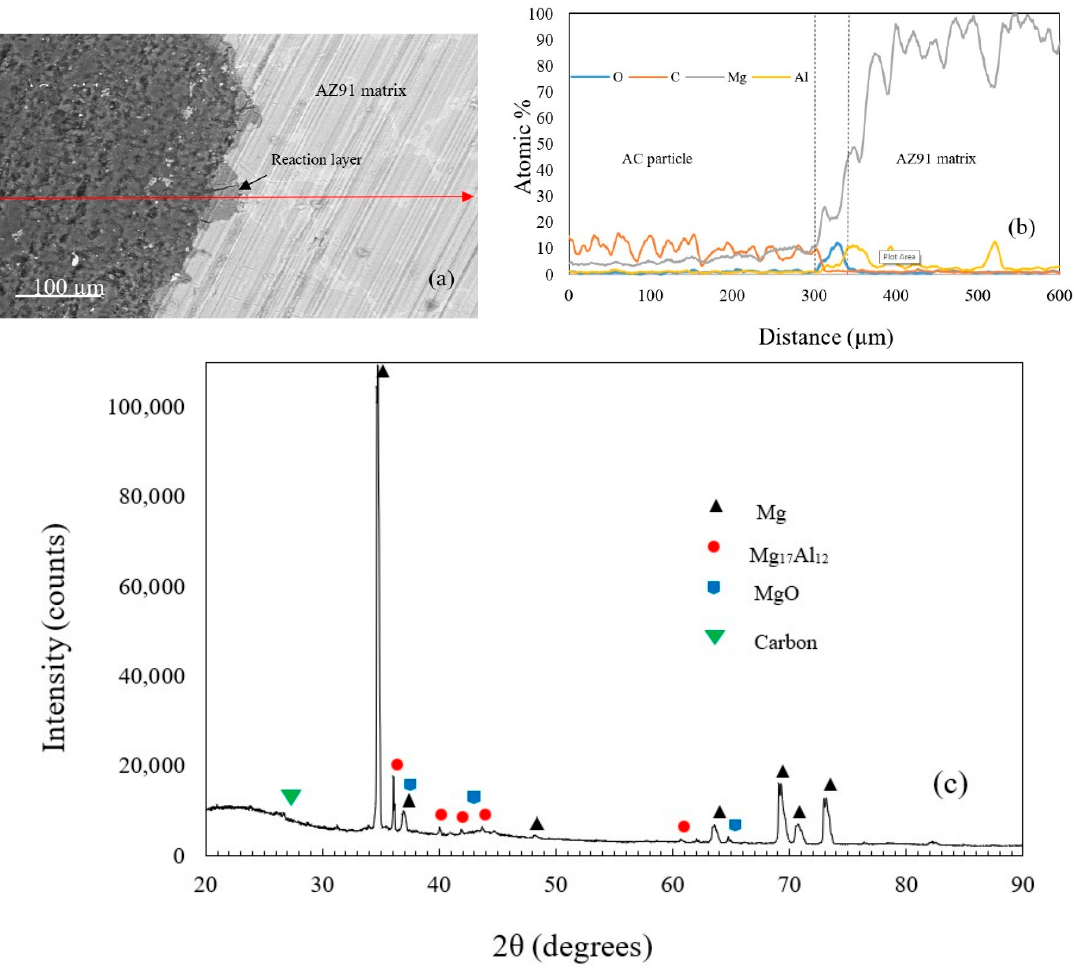
Figure 3. ( a ) SEM images of the interface between the matrix and an AC particle, ( b ) an EDS line scan, ( c ) the XRD pattern of the AZ91–AC syntactic